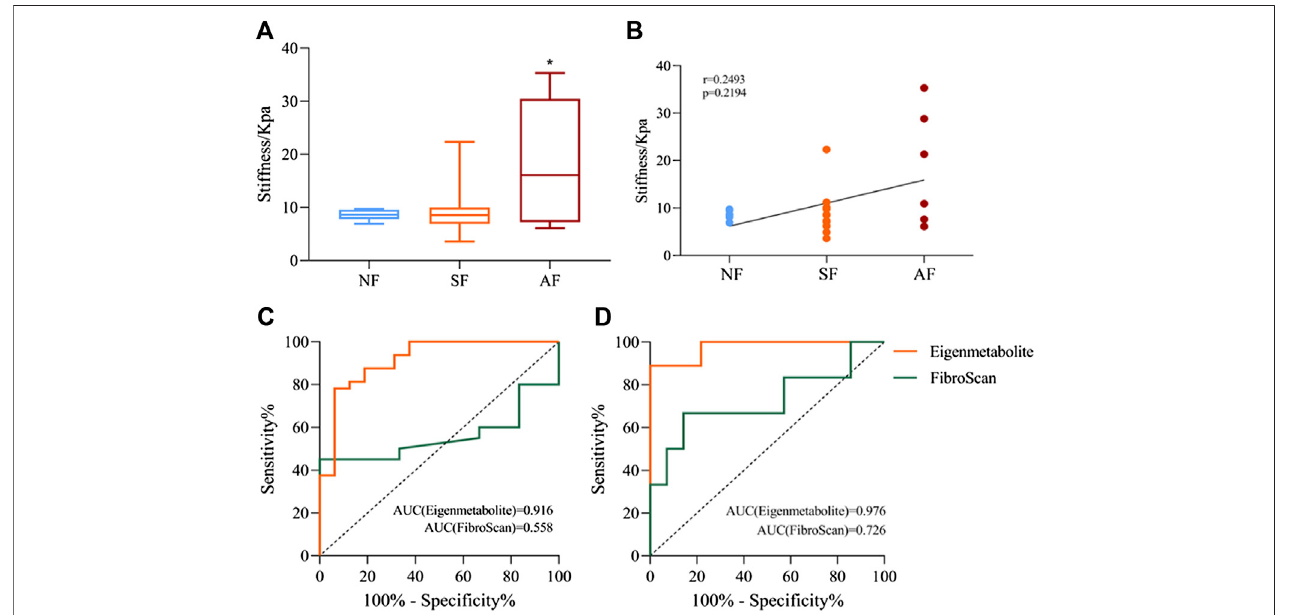
FIGURE6 | Comparison of metabolite fi ngerprints and FibroScan in theidenti fi cation of liver fi brosisgrade. (A) Liver stiffness values measured by FibroScan inNF, SF, andAFgroups. (B) Spearman ’ scorrelationanalysisbetweenliverstiffnessand fi brosisgrade,withtherand p valuesindicated. (C) Receiver operatingcharacteristic (ROC) curves ofmetabolite fi ngerprint(eigenmetabolite) and FibroScanforthediagnosisof fi brosis and nonsigni fi cant fi brosispatientswithchronic DILI. (D) ROCcurves ofthemetabolite fi ngerprint(eigenmetabolite)andFibroScanforthediagnosisofadvanced fi brosisfromsigni fi cantpatientswithchronicDILI.Dataarepresentedas mean ± SD. * p < 0.05, compared with the NF group. NF, nonsigni fi cant fi brosis; SF, signi fi cant fi brosis; AF, advanced fi